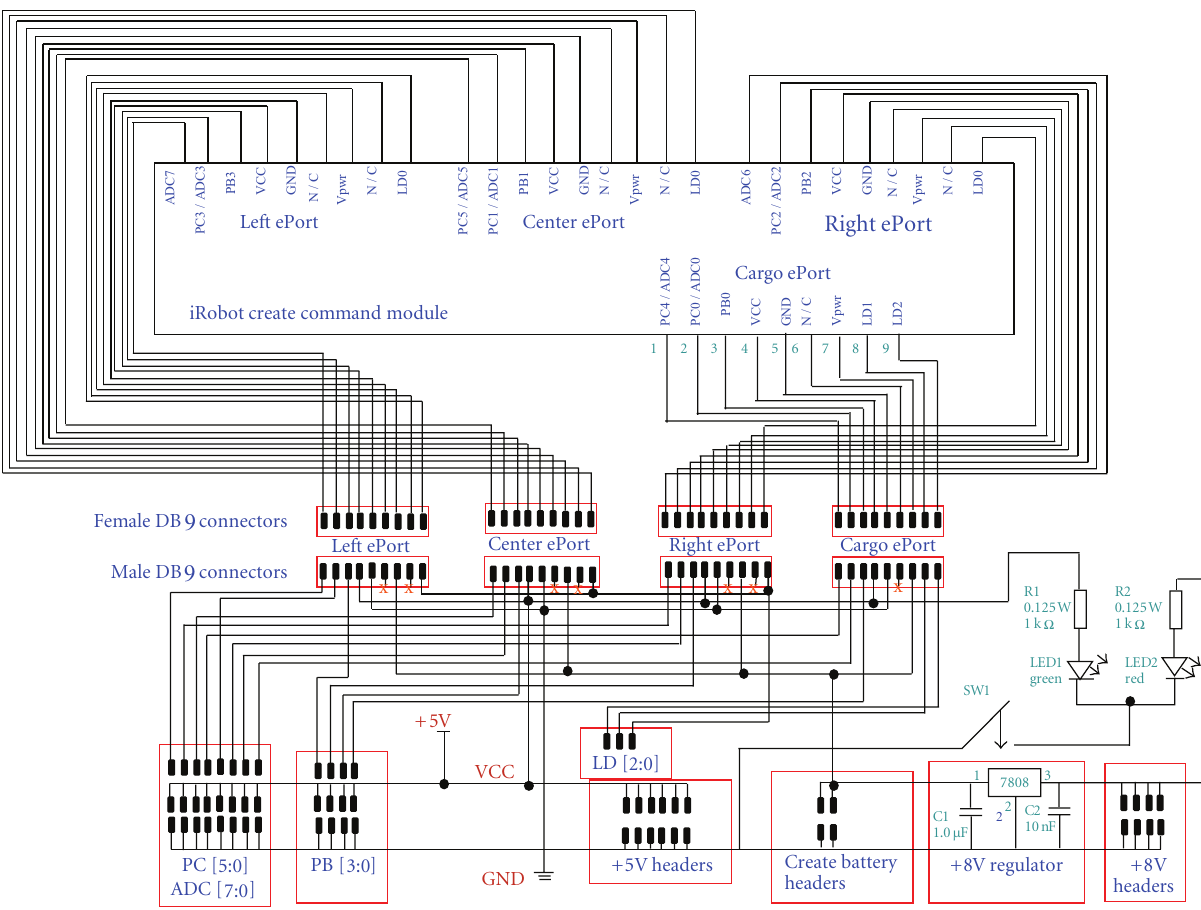
Figure 12: Command module re-pin out circuit